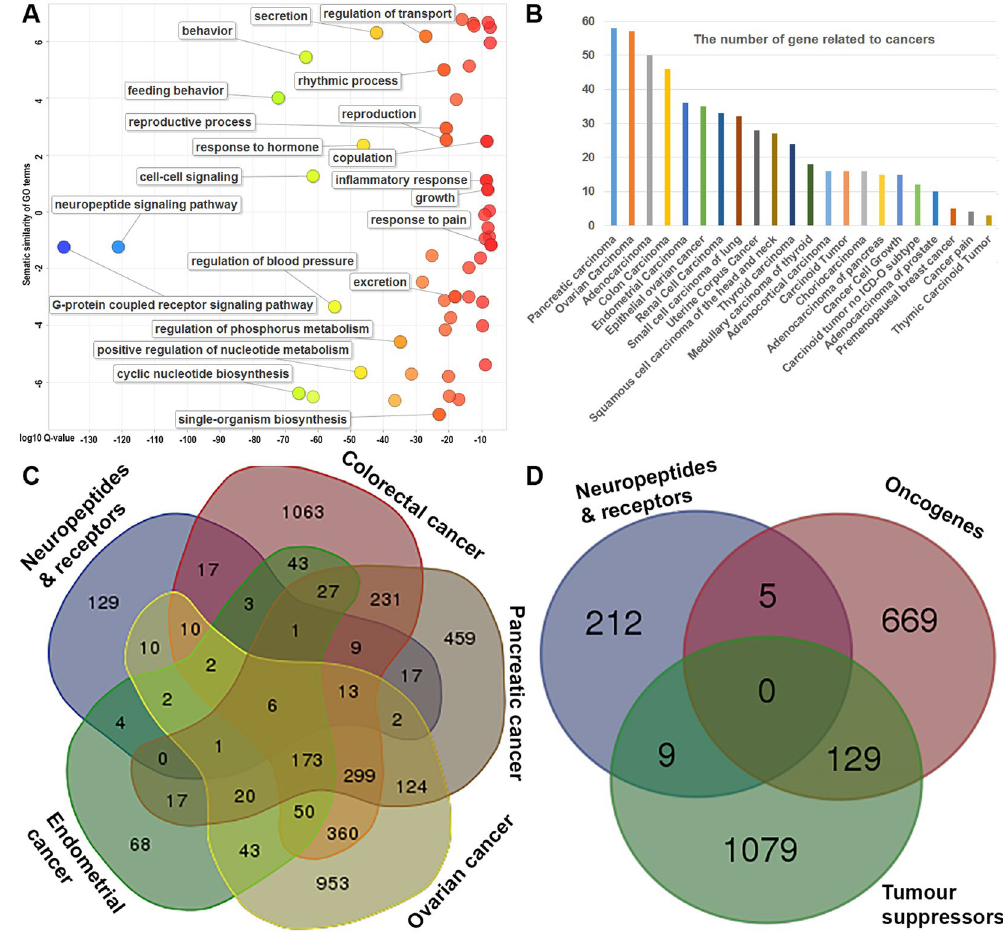
Figure 2. Functional analysis of the 93 neuropeptides and 133 receptors. ( A ) Scatterplot showing the biological process cluster representatives terms from gene ontology (GO) for the 127 neuropeptides in a two-dimensional space derived by applying multidimensional scaling to a matrix of the GO terms’ semantic similarities. Y-axis indicates the similarity of the GO terms; x-axis indicates the log of corrected P-value (bubbles of right corrected P-values are larger). ( B ) Graph showing significantly enriched cancer-related terms for 93 neuropeptides and 133 receptor genes in human. ( C ) Venn diagram showing comparative overlap based on four literature-based cancer databases. ( D ) Venn diagram showing overlap of tumour suppressors and